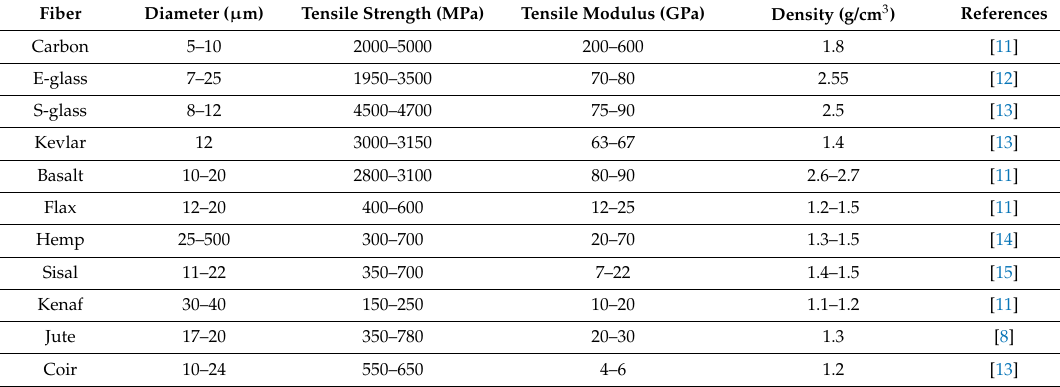
Table 1. Some properties of carbon, basalt, and some vegetable